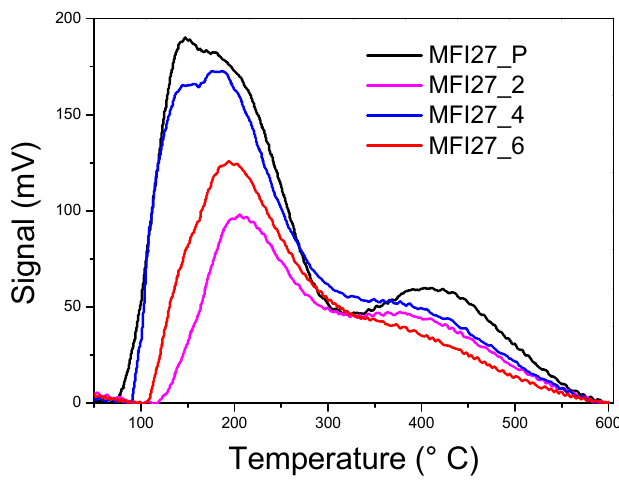
Figure 6. Ammonia temperature programmed desorption (NH 3 -TPD) profile of as-received ZSM-5 and alkali-treated zeolite samples.